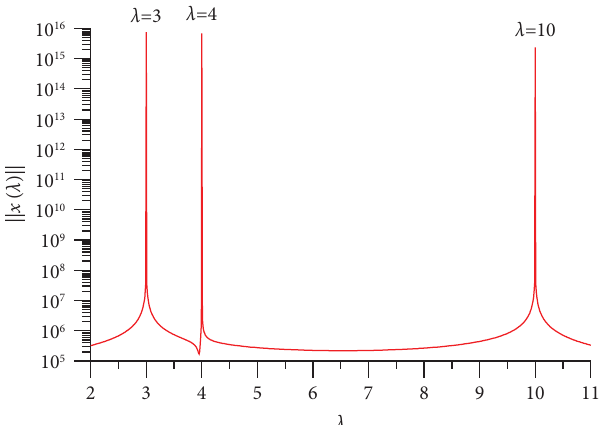
Figure 8: For Example 6 of a nonsymmetric matrix, showing three picks of ‖ x ‖ , corresponding to eigenvalues 3, 4, and 10.